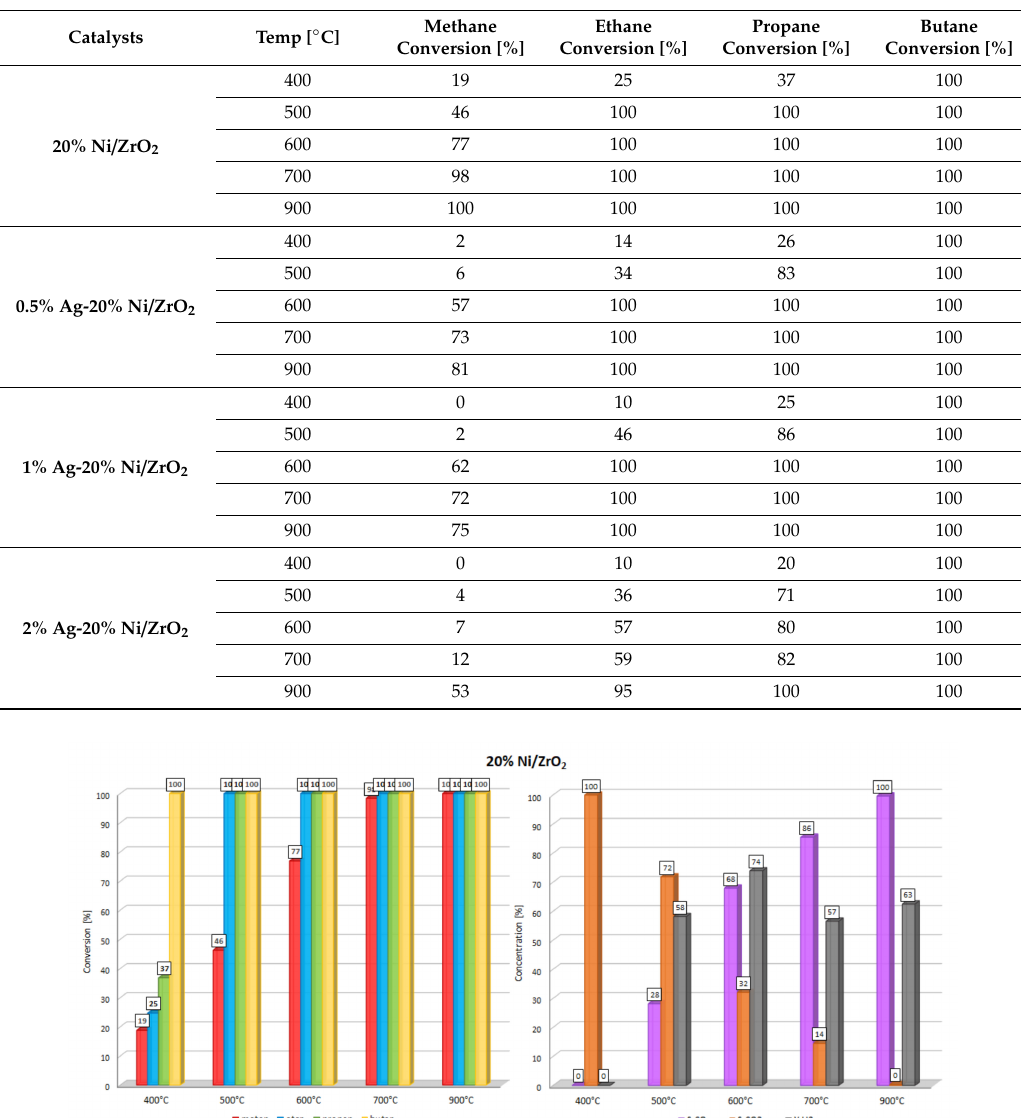
Table 2. Conversion values of the hydrocarbons obtained in the oxy-steam reforming of liquefied natural gas (LNG) process over mono- and bimetallic supported catalysts.